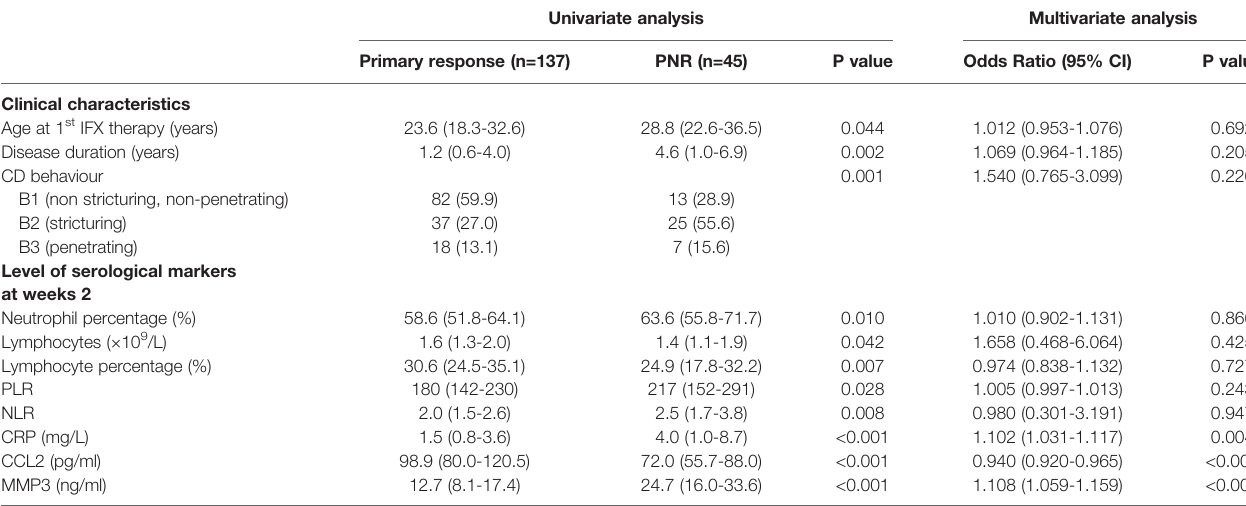
TABLE 3 | Signi fi cant univariate association of clinical characteristics and serological markers for primary non-response in cohort